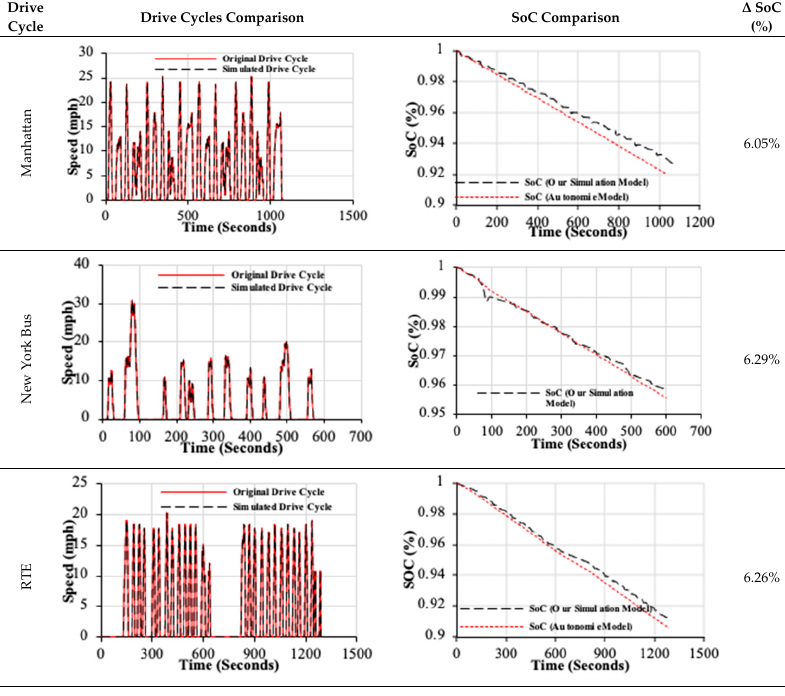
Figure A2. Autonomie based energy consumption model validation.